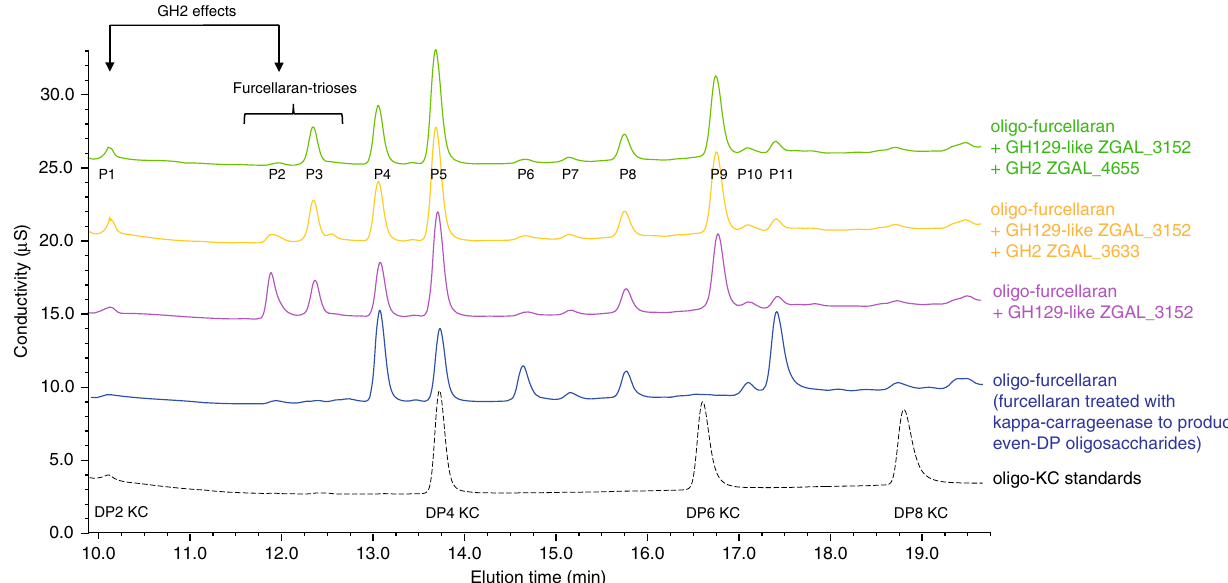
Fig. 7 Sequential digestion of furcellaran oligosaccharides by DagB and GH2 enzymes. HPLC results for the ZGAL_3152 (DagB, GH129-like) and GH2 (ZGAL_3633, ZGAL_4655) sequential enzyme digests on furcellaran oligosaccharides. Oligo-kappa-carrageenan standards (DP2, DP4, DP6, and DP8) are shown in black dotted line on the chromatogram. First, oligo-furcellaran (blue line) was treated with ZGAL_3152 (purple line). This reaction was then stopped by heating at 90 °C for 10 min. Following the inactivation of ZGAL_3152 the oligosaccharides were treated with either ZGAL_3633 (orange line) or ZGAL_3655 (green